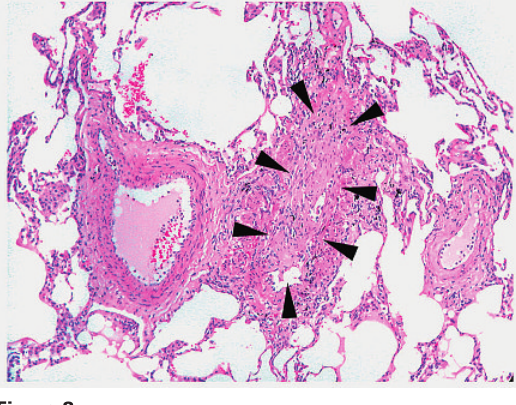
Chronic rejection (obliterative bronchiolitis).The terminal bronchiole is delineated by arrows and filled with dense fibrous material (haematoxylin-eosin, magnification 25x).